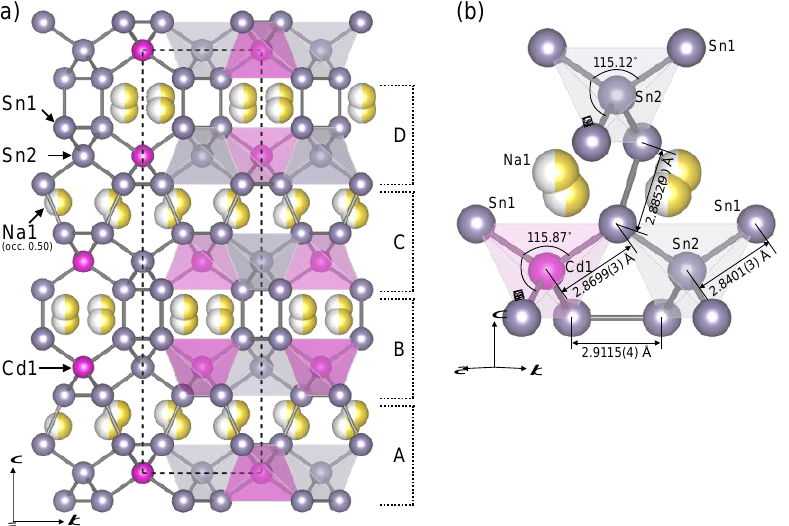
Figure 4. Crystal structure of Na 2 CdSn 5 : a projection on the b - c plane ( a ) and an arrangement of Cd – Sn tetrahedra ( b ).